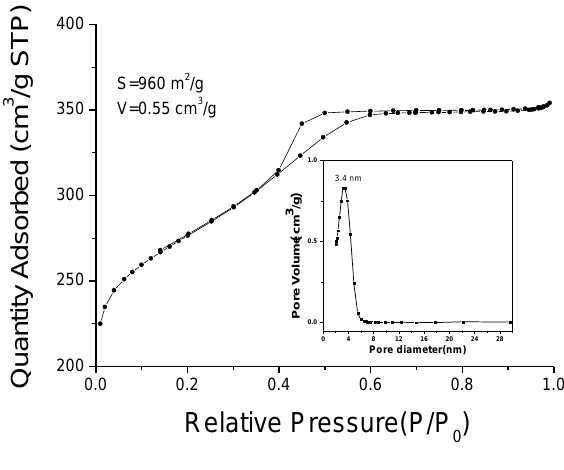
Figure 3. N adsorption curves of the mesoporous carbon 2